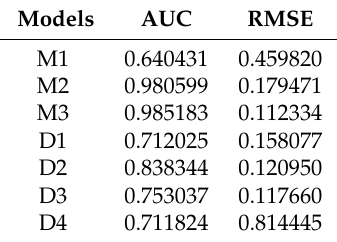
Table 10. Performance for the seven models using the top 10 features from model D3 on the test dataset.